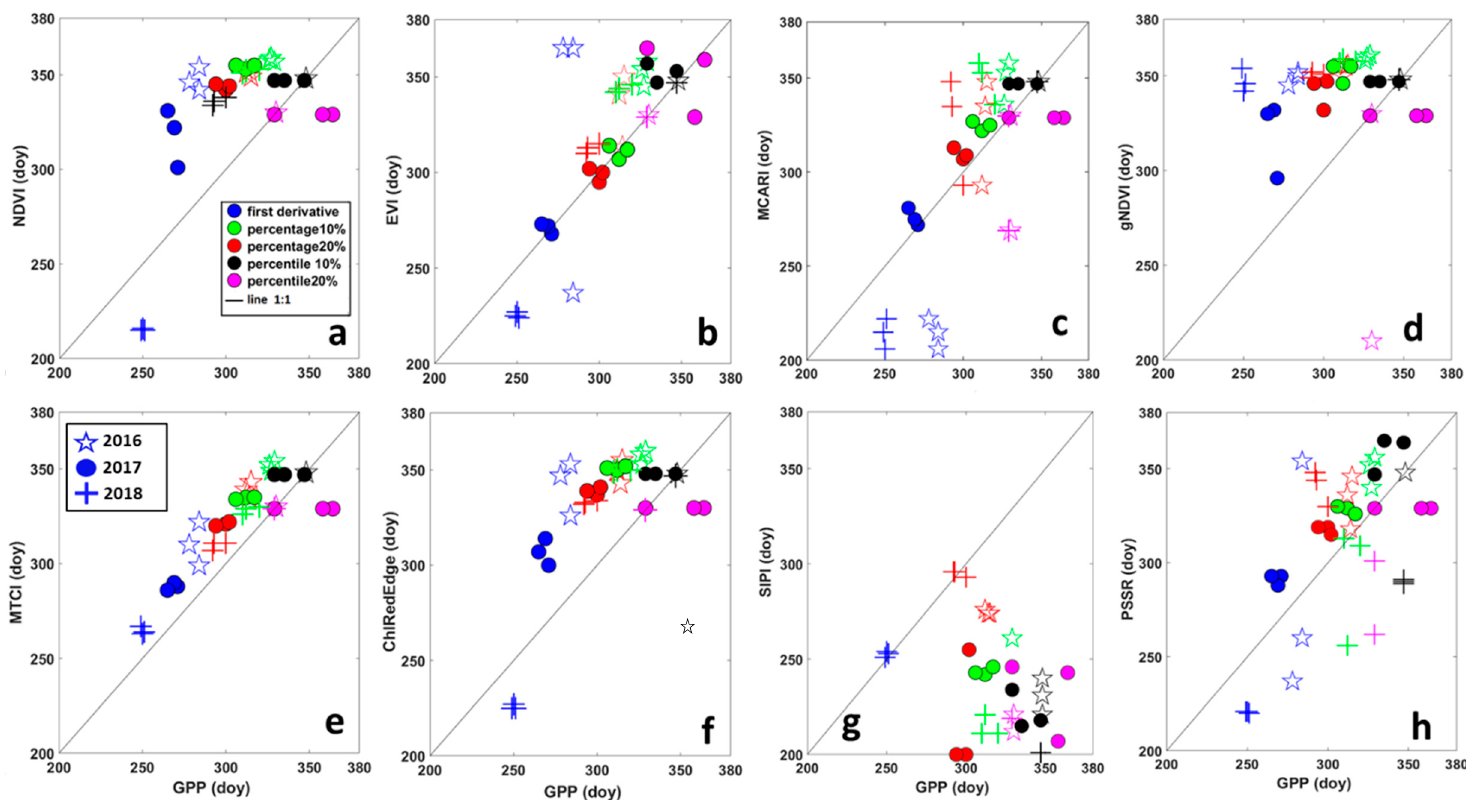
Figure 5. Relationship between the end of the season (EOS), in days, derived from Gross Primary Productivity (GPP) and different vegetation indices. ( a ) NDVI—Normalized Difference Vegetation Index; ( b ) EVI—Enhanced Vegetation Index; ( c ) MCARI—Modified Chlorophyll Absorption Ratio Index; ( d ) gNDVI—Green Normalized Difference Vegetation Index; ( e ) MTCI—MERIS Terrestrial Chlorophyll Index; ( f ) ChlRedEdge—Chlorophyll red-edge; ( g ) SIPI—Structure Insensitive Pigment Index; and ( h ) PSSR—Pigment Specific Simple Ratio. Different colors represent different methods for deriving SOS: blue = first derivative method; green = percentage 10%; red = percentage 20%; black = percentile 10%; pink = percentile 20%. Symbols show different years: stars ( ) are for 2016; circles ( ● ) for 2017 and plus (+) for 2018.